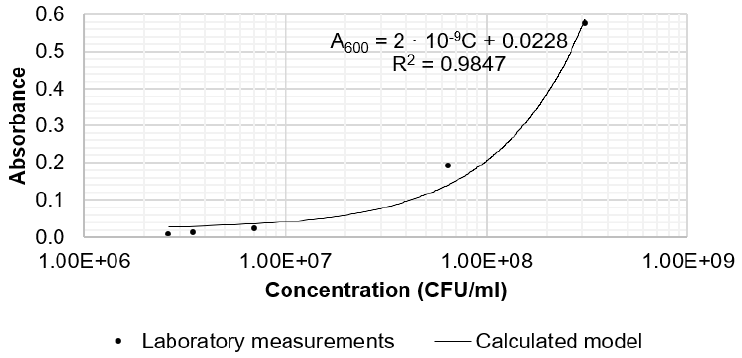
Figure 4 – Spectrophotometric behavior of B. subtilis